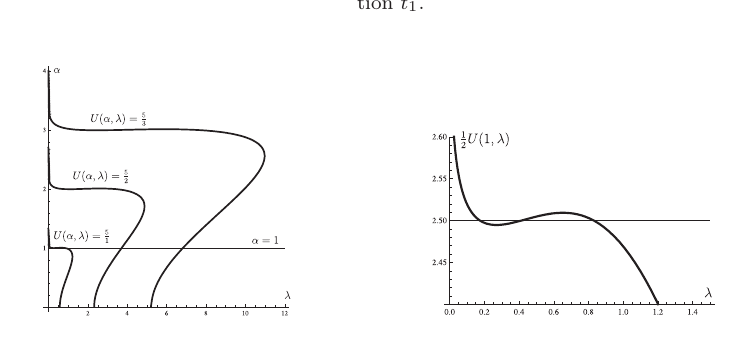
Figure 4. The curves Γ i for i = 1 , 2 , 3 . Figure 5. The graph of the function